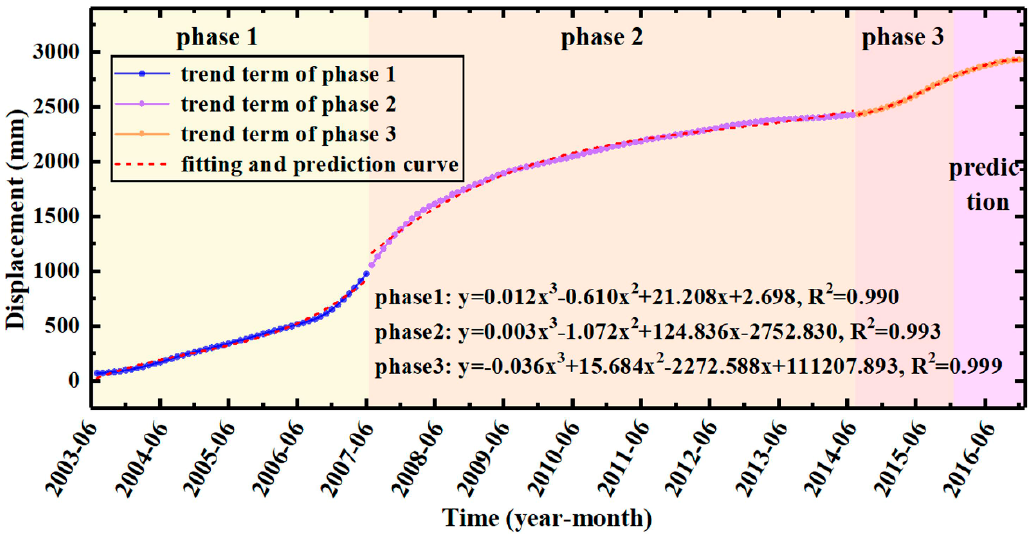
Table 7. Parameters of the trend term of displacement based on polynomial fitting.